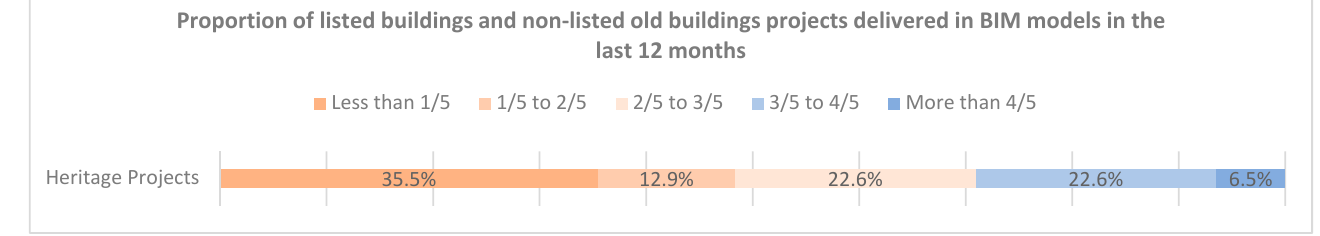
Figure 15. Proportion of heritage and old buildings projects delivered in BIM models in the last 12 months from surveys performed by terrestrial 3D laser scanning and digital photogrammetry.